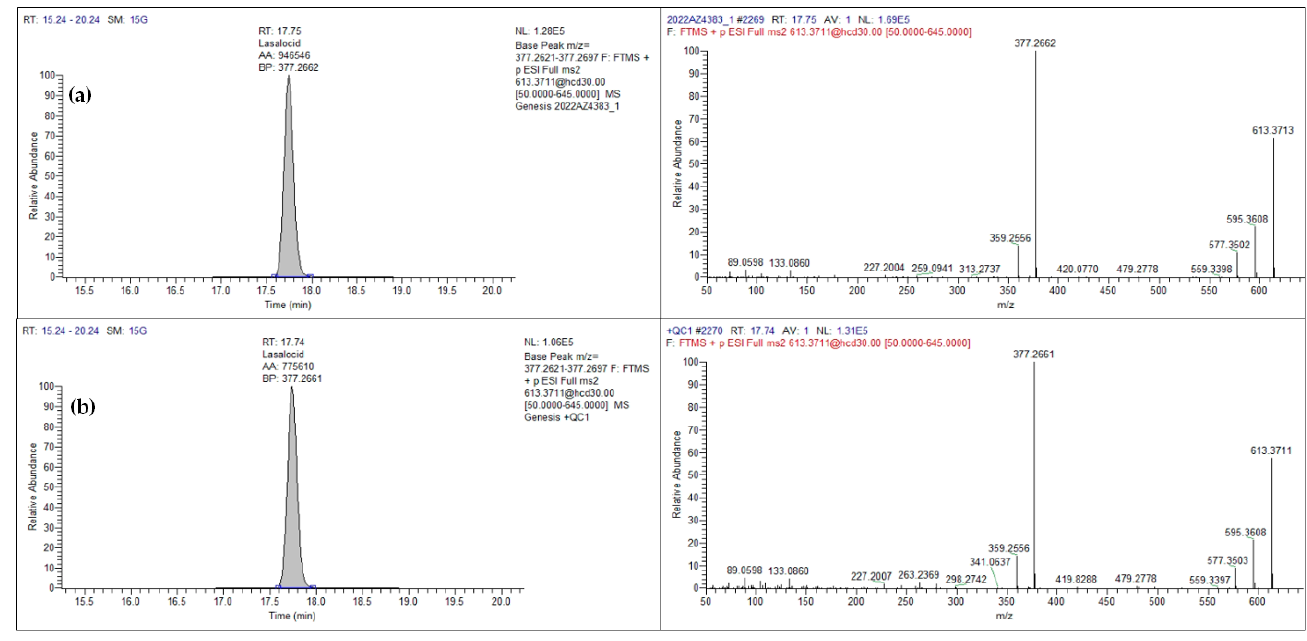
Figure 7. Chromatograms (left) and product ion spectra (right) of lasalocid in an egg sample at 1.2 µg kg − 1 ( a ) and in a spiked sample at 1 µg kg − 1 ( b ).